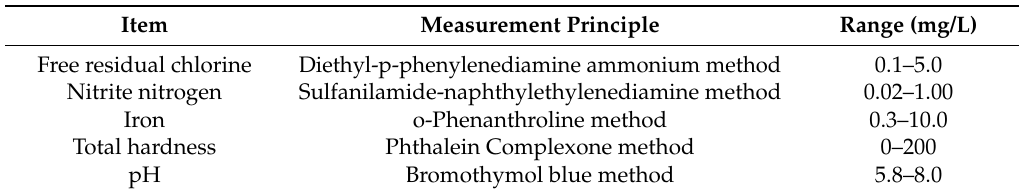
Table 3. Tap water quality analysis